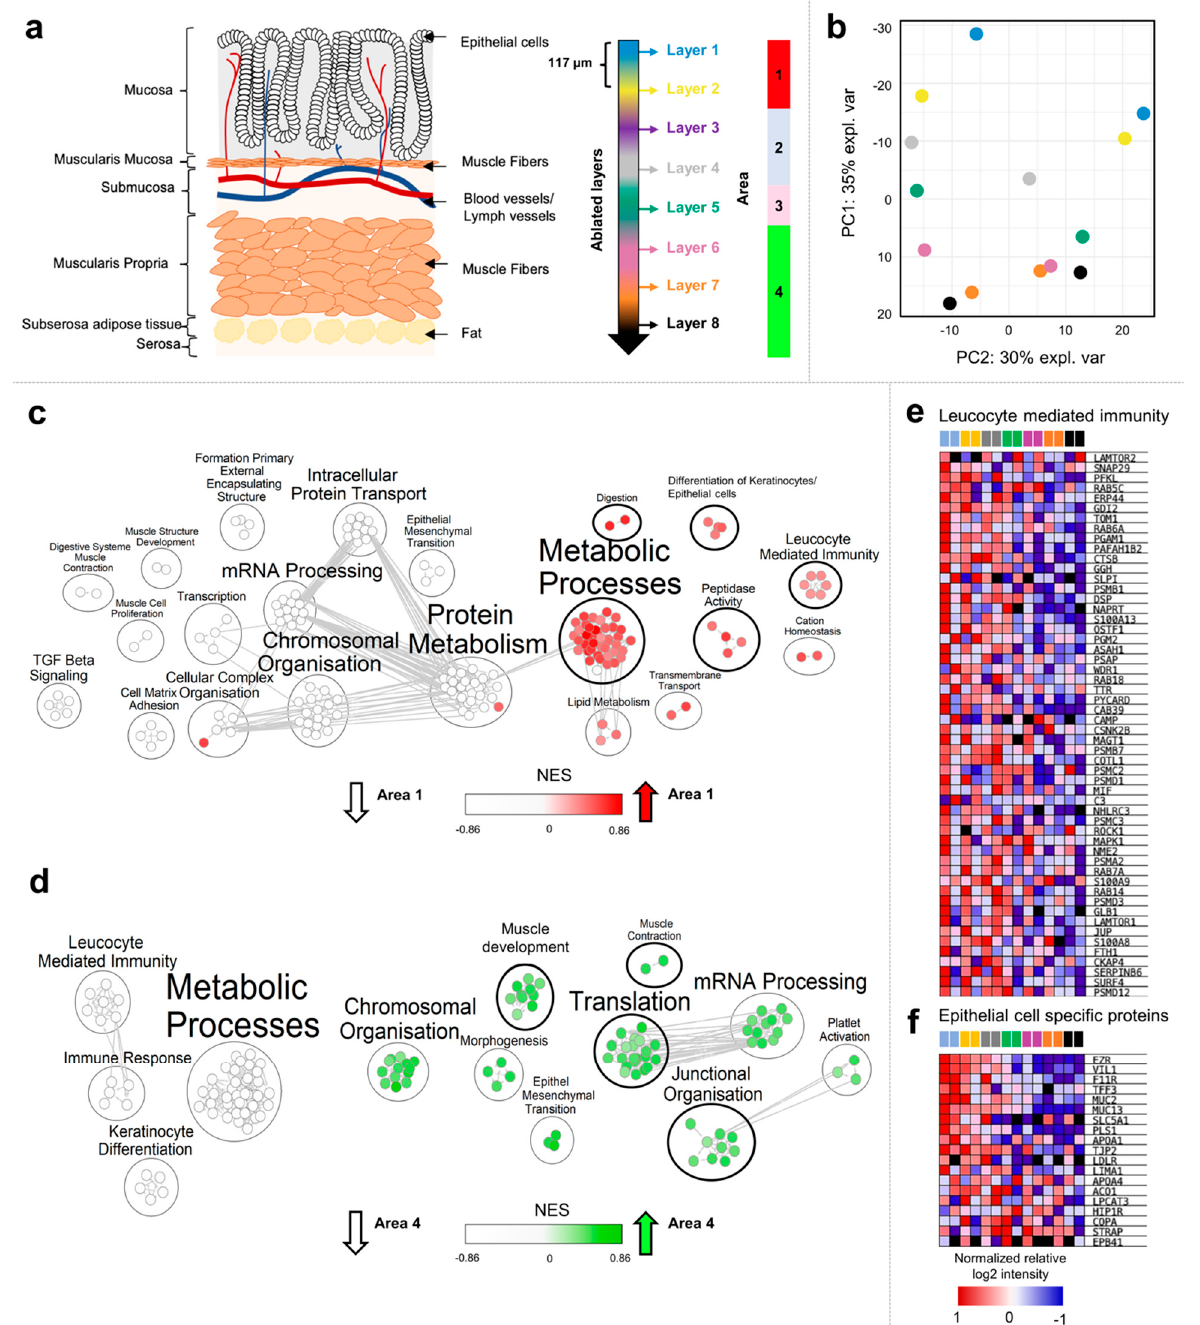
Figure 2. Comparison of different cellular layers of the murine intestine after NIRL ablation. ( a ) Schematic overview of the colon layer structure and the location of ablated layers and disclosed proteomic signatures along the sagittal axis of the colon. ( b ) Scatter plot visualization of the first 2 principal components from nonlinear iterative squares (NIPALS) PCA. ( c ) Positively (red) and negatively (white) enriched gene ontology biological processes (GO--PB) in area 1. ( d ) Positively (green) and negatively (white) enriched gene ontology biological processes (GO--PB) in area 4. Heatmap visualization of the relative abundance distribution of proteins assigned to the gene set “Leucocyte mediated immunity” ( e ) and to “Epithelial cell specific proteins” ( f ) across ablation layers.